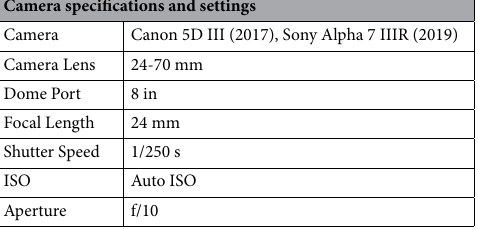
Table 1. Camera specifications and settings used for photogrammetry surveys.